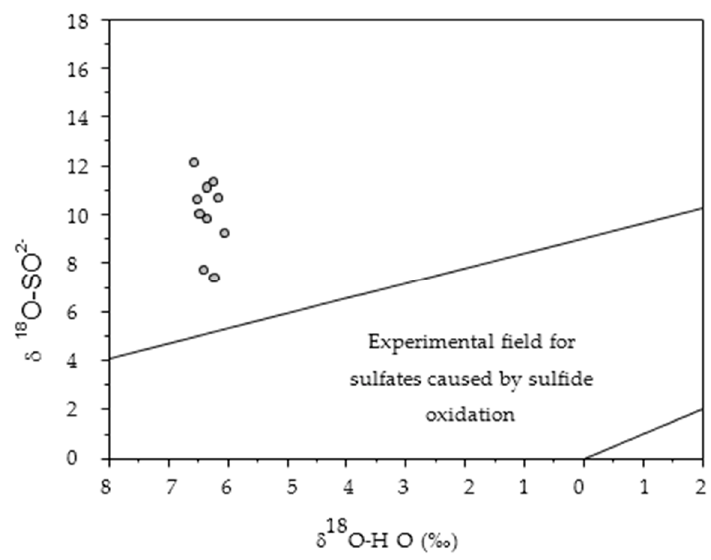
Figure 7. Representation of δ 18 O of water versus δ 18 O of sulfate to determine the origin of sulfide oxidation.